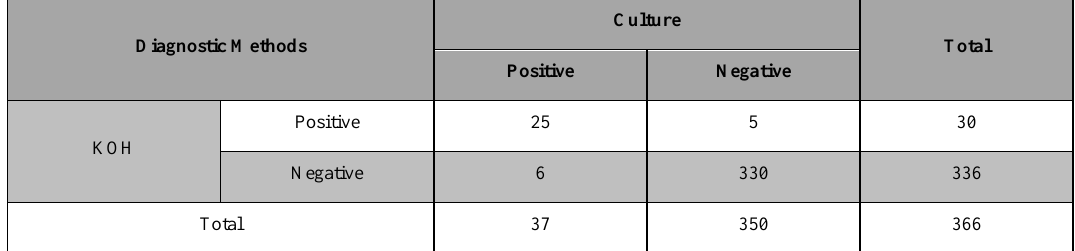
Table 3. KOH and Culture Statistical association in diagnosing fungi.